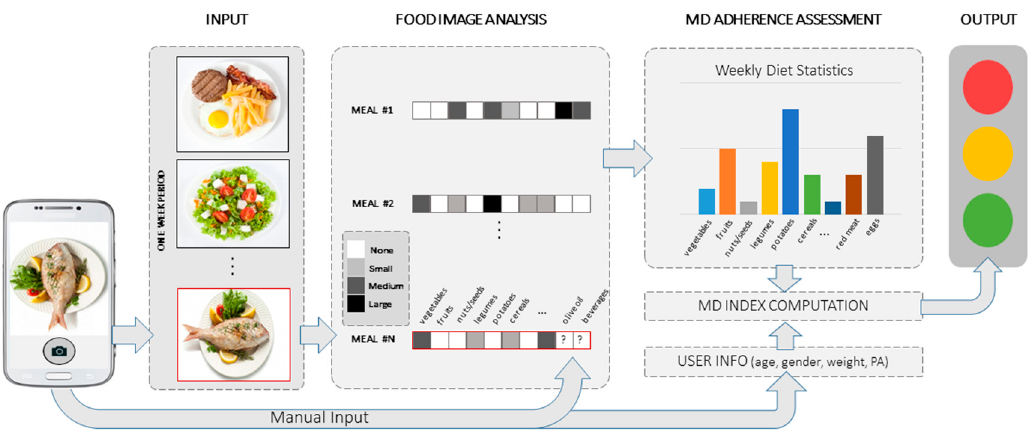
Figure 1. Outline of the medipiatto system.